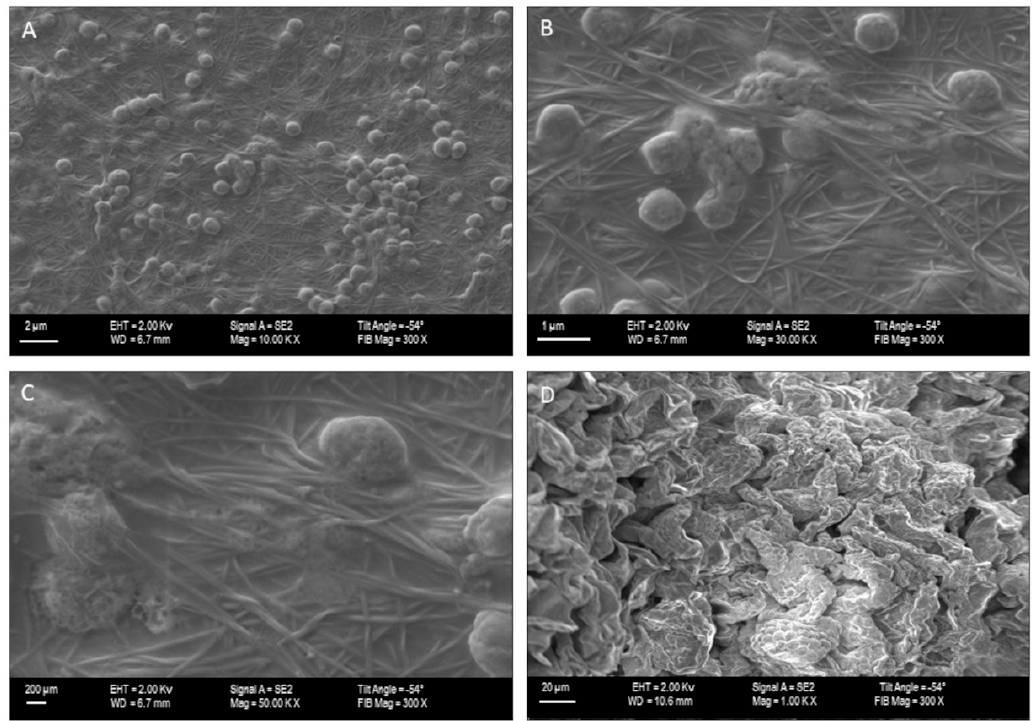
Figure 2. The C. majus cellular aggregates (oval shapes) on the 3-day-old NC fibrinous mesh. ( A ): magnification 10,000×; ( B ): 30,000×; ( C ): 50,000×, ( D ): close-up on C. majus cells, 100,000×. Microscope SEM Zeiss Auriga 60.